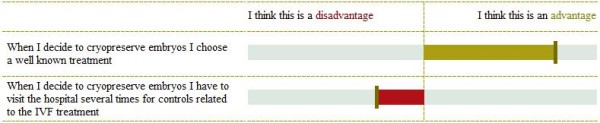
Example of a statement in the value clarification exercise (cryopreservation of ovarian tissue). For each statement in the value clarification exercise, patient rate whether it is an advantage (green; right side of the figure) or disadvantage (red; left side of the figure) and the extent to which the statement is considered important in decision making about FP (by lengthening or shortening the bar) [18].